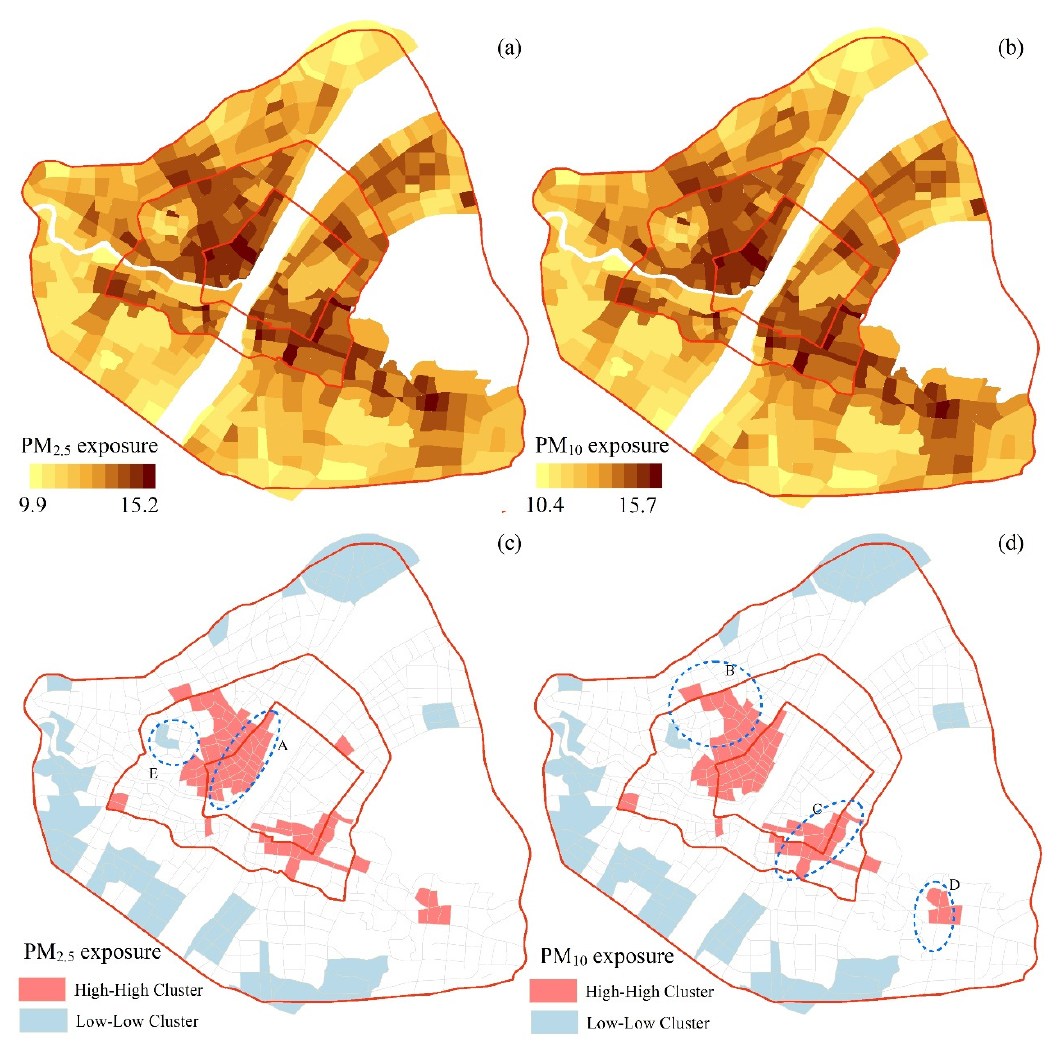
Figure 7. PM 2.5 and PM 10 exposure maps.